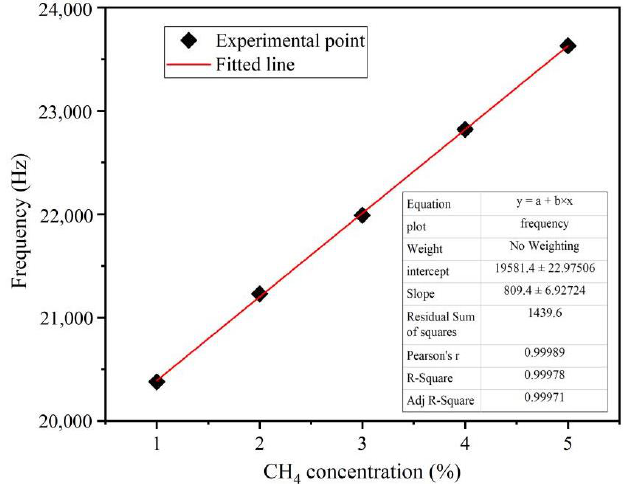
Figure 11. Linear fitting diagram of sensor response and CH 4 concentration.